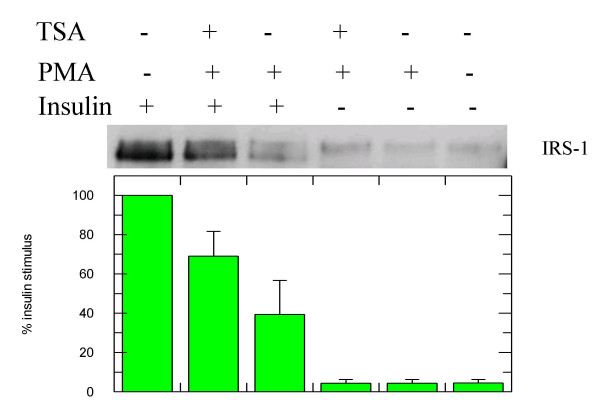
Increases in IRS-1 lysine acetylation enhance insulin signalling to IRS-1. MCF-7 cells were treated with PMA and/or TSA for 4 hours (concentrations as in Figure 3) prior to stimulation with 100 nM insulin for 10 minutes. IRS-1 was immunoprecipitated and blotted for the presence of phosphotyrosine. The graph summarises results from 3 experiments (± SEM) normalised to the response to insulin stimulation alone.